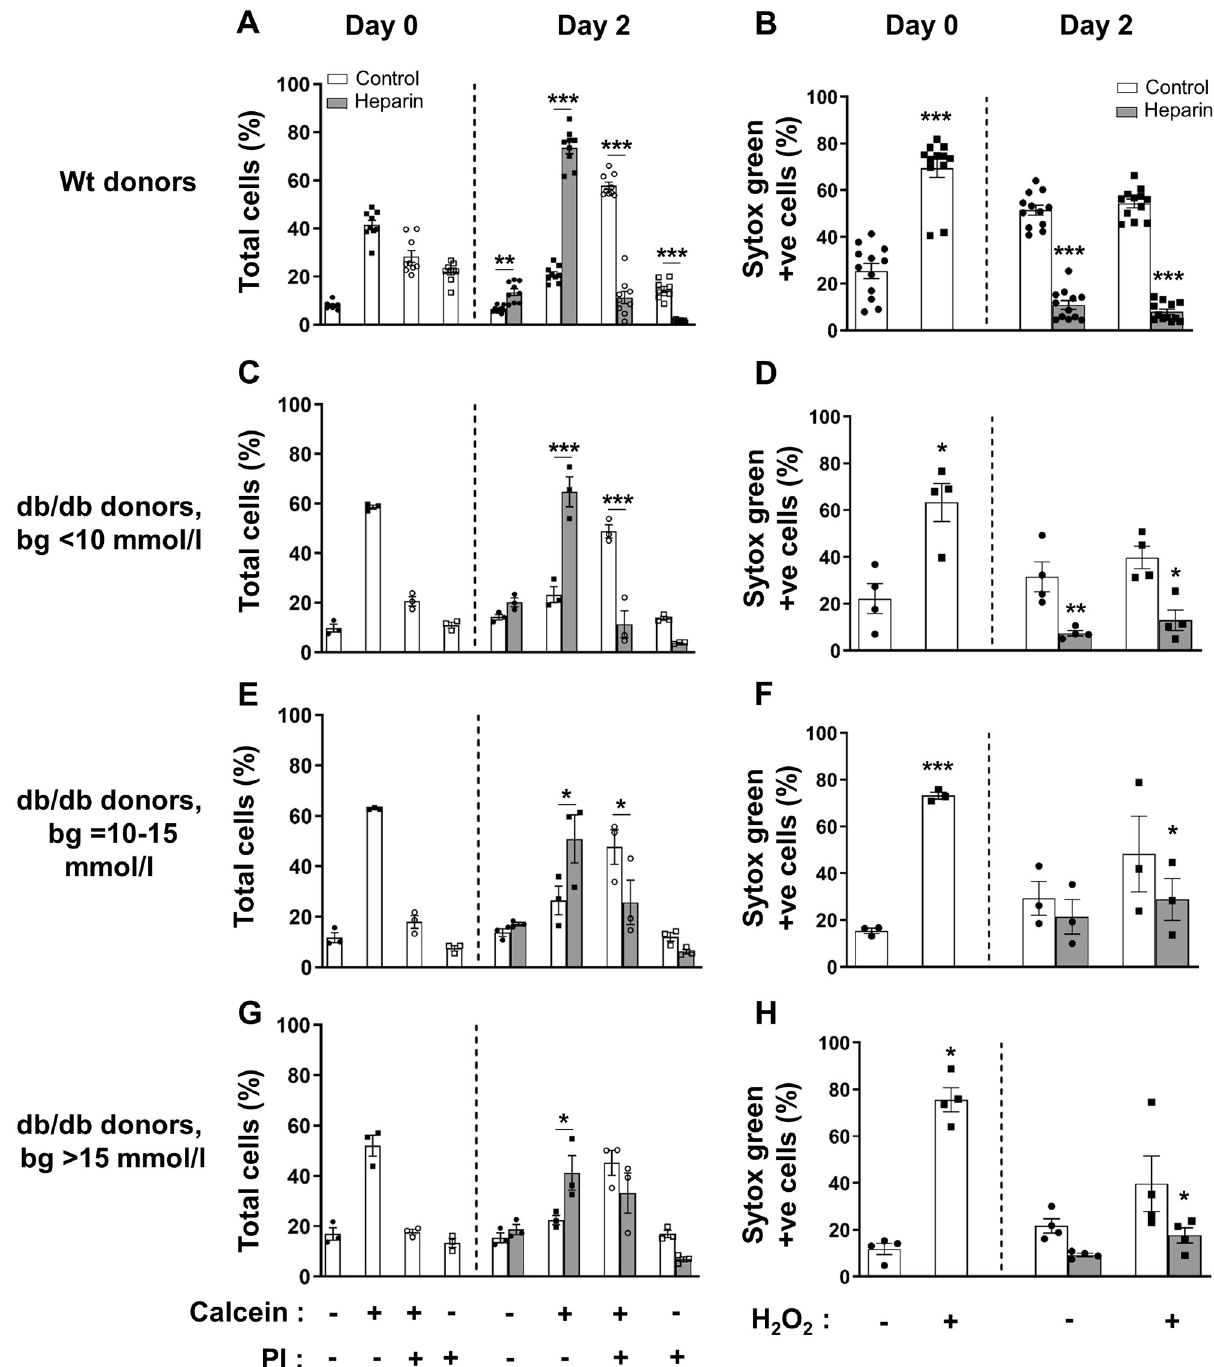
Fig 7. HS replacement protects db/db beta cells from dying in culture and from acute hydrogen peroxide-induced damage. The viability of ( A ) wt and ( C, E, G ) db/db beta cells was analyzed by flow cytometry using the fluorescent dyes Calcein (Cal) and PI after culture for 2 days without (open bars) or with (shaded bars) the highly sulfated HS analogue heparin (50 μ g/ml). Cell death/damage due to acute treatment with hydrogen peroxide was measured by uptake of the fluorescent dye Sytox Green. Donors were ( A, B ) wt; ( C, D ) normoglycemic db/db (bg < 10 mmol/l); ( E, F ) mildly hyperglycemic db/db (bg = 10–15 mmol/l) and ( G, H ) severely hyperglycemic db/db (bg > 15 mmol/l). Beta cells were identified as viable (Cal + PI - ), damaged (Cal + PI + ) or dead (Cal - PI + ) and expressed as % total cells; alternatively, damaged/dead cells were identified as Sytox Green+ve. Data represent mean ± SEM for n = 3–11 experiments/group; n = 2–4 male donors/experiment. � p < 0.05, �� p < 0.01 and ��� p < 0.0001, ANOVA with Fisher’s unprotected LSD post-test.